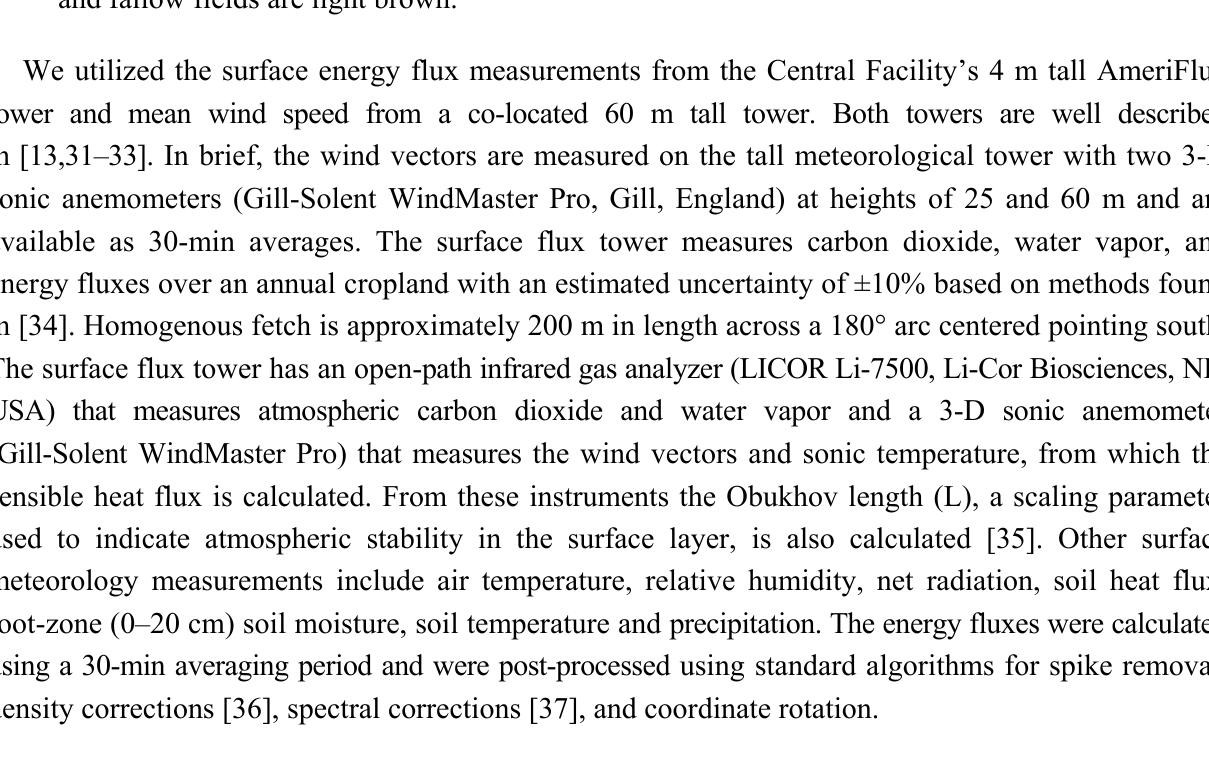
Figure 1. ( a ) Map showing the boundaries of the greater Southern Great Plains (SGP) Atmospheric Radiation Measurement (ARM) Facility in Oklahoma and Kansas (yellow box) including the Central Facility near Lamont, Oklahoma; ( b ) Aerial photograph of the Central Facility depicting the fine-scale spatial heterogeneity in the area and locations of instruments used in this study. Live crops are indicated by dark green while pasturelands and fallow fields are light